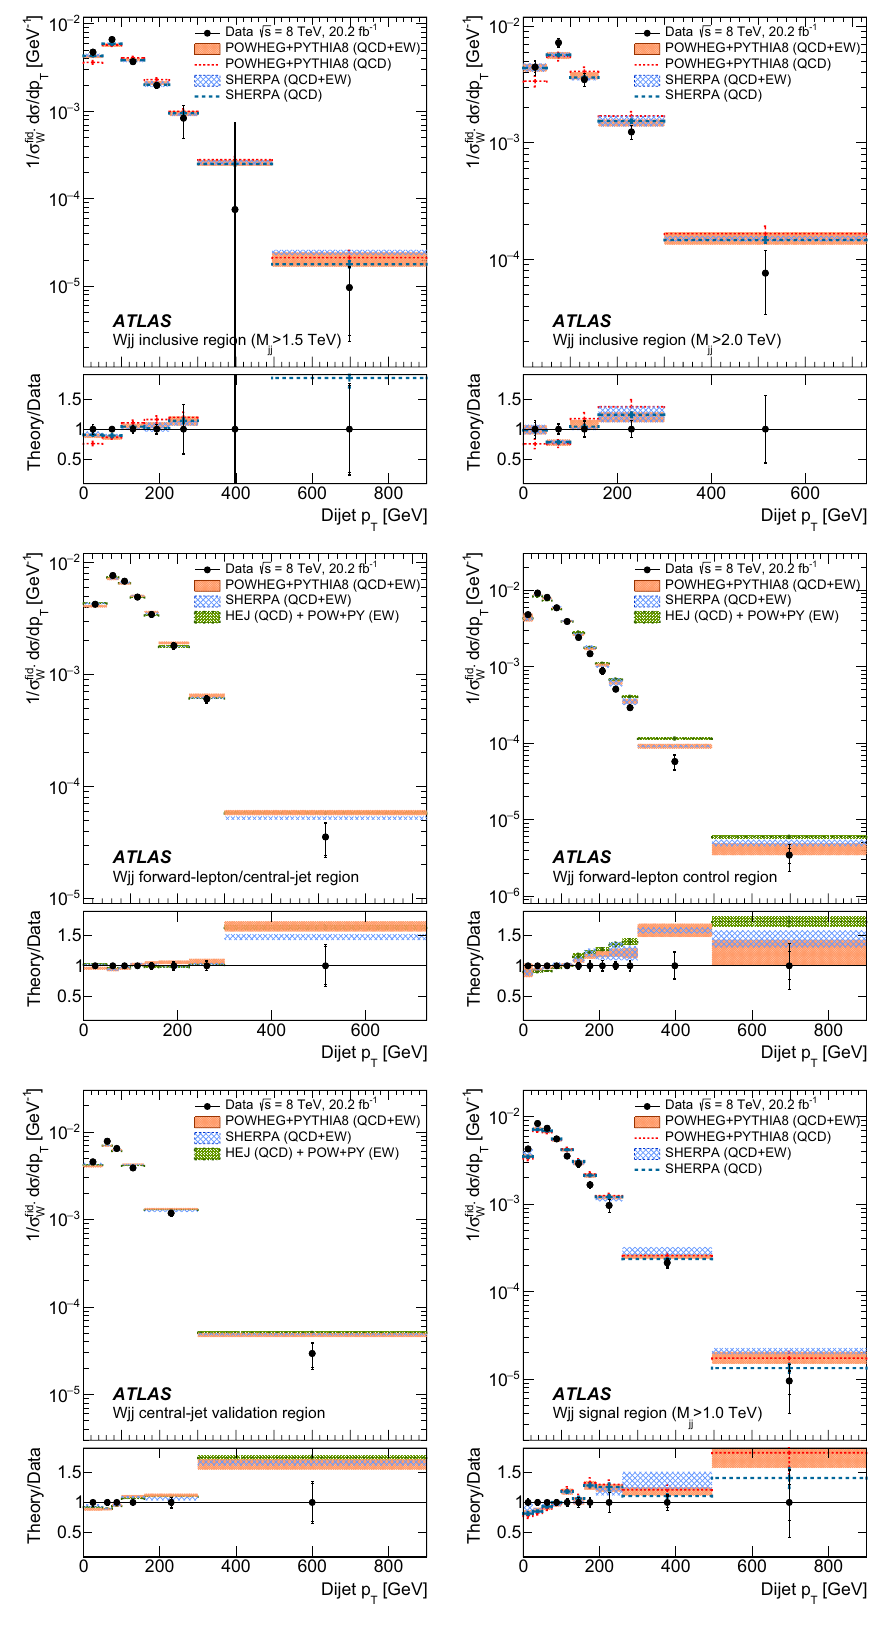
Fig. 44 Unfolded normalized differential W jj production cross sections as a function of dijet p T in the inclusive ( top ), forward-lepton/central-jet ( middle left ), forward-lepton ( middle right ), central-jet ( bottom left ), and high-mass signal ( bottom right ) fiducial regions. The inclusive regions show the distributions for M jj thresholds of 1.5 TeV ( left ) and 2.0 TeV ( right ). Both statistical ( inner bar ) and total ( outer bar ) measurement uncertainties are shown, as well as ratios of the theoretical predictions to the data (the bottom panel in each